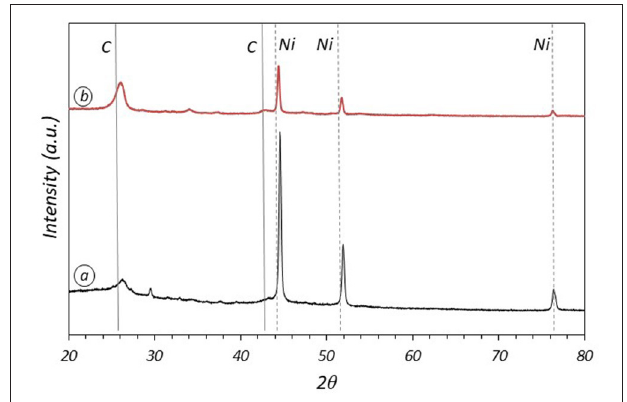
FIGURE 3 | XRD pattern of fresh catalyst (a) and after reaction at 950 ◦ C (b) .